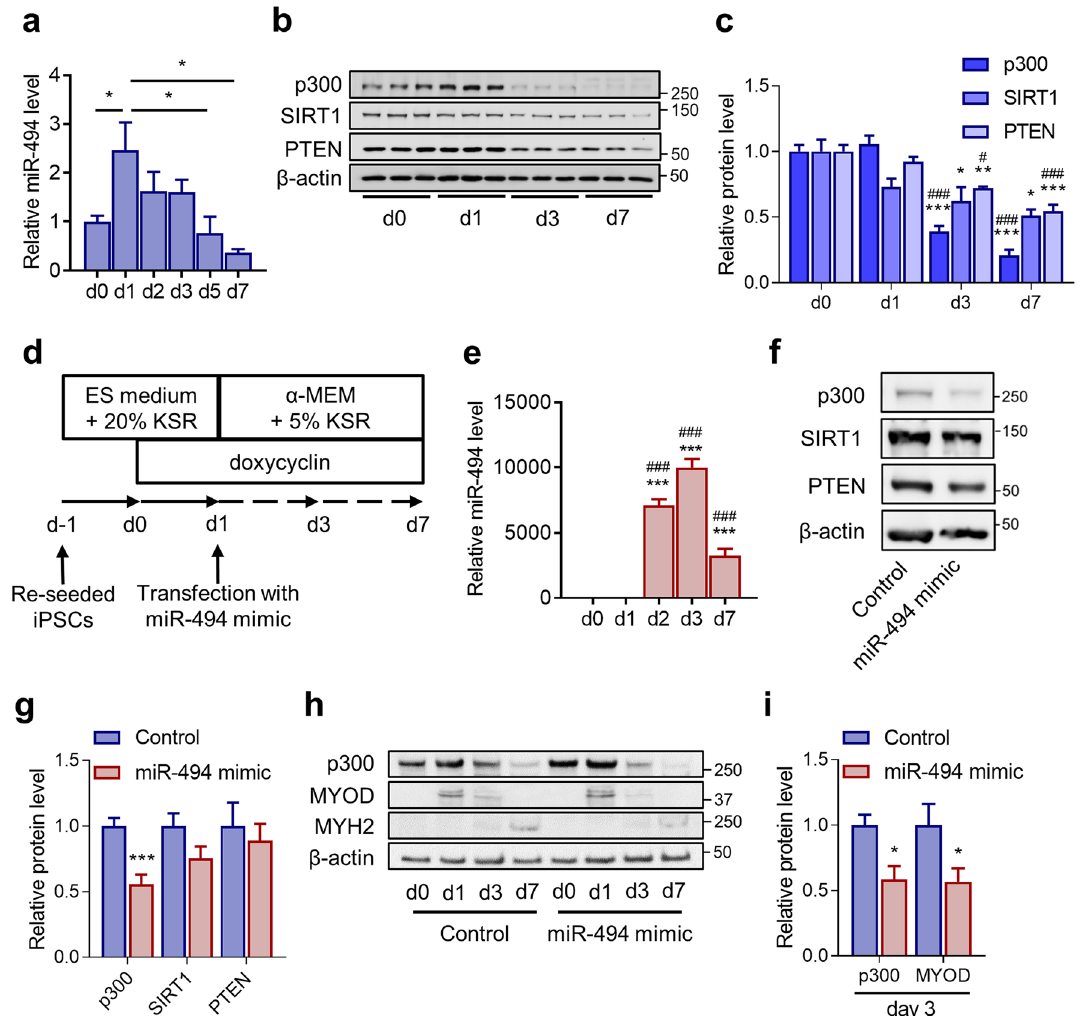
Figure 1. Effects of miR-494 mimic on human-skeletal myogenesis in MyoD-hiPSCs. ( a ) Time course of miR- 494 expression during MyoD-hiPSC differentiation, as analysed by Taqman RT-qPCR. Data were normalised with snRNA U6. n = 4–6. * p < 0.05. ( b,c ) Time course of p300, SIRT1, and PTEN expression during MyoD- hiPSC differentiation, as analysed by immunoblotting. Expression of p300, SIRT1, and PTEN was quantified using Image J and normalised to β-actin expression. n = 3. * p < 0.05, ** p < 0.01, *** p < 0.001 versus day 0. # p < 0.05, ### p < 0.001 versus day 1. Full-length blots are presented in Supplementary Figure S4. ( d ) Schematic diagram showing transfection of MyoD-hiPSCs with miR-494 mimic at day 1. ( e ) Time course of miR-494 expression during differentiation of MyoD-hiPSCs transfected with miR-494 mimic, as analysed by Taqman RT-qPCR. Data were normalised with snRNA U6. n = 3. *** p < 0.001 versus day 0. ### p < 0.001 versus day 1. ( f,g ) MyoD-hiPSCs were transfected with miR-494 mimic or negative control duplexes (Control). Whole-cell extracts were harvested at day 7 after myogenic induction; expression of p300, SIRT1 and PTEN was evaluated using immunoblots. Data were normalised to β-actin. n = 6. *** p < 0.001 versus control. Full-length blots are presented in Supplementary Figure S5. ( h ) Time course of p300, MYOD, and MYH2 expression during differentiation of MyoD-hiPSCs transfected with miR-494 mimic or Control, as analysed by immunoblotting. Full-length blots are presented in Supplementary Figure S6. ( i ) MyoD-hiPSCs transfected with miR-494 mimic or Control were harvested at day 3 after myogenic induction; expression of p300 and MYOD was evaluated using immunoblots. Data were normalised to β-actin. n = 5. * p < 0.05 versus